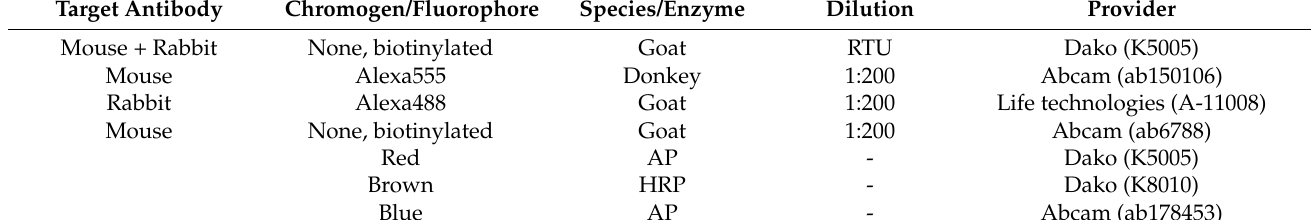
Table 2. Secondary antibodies, chromogens, fluorophores and metals. Except DAPI, the fluoro-